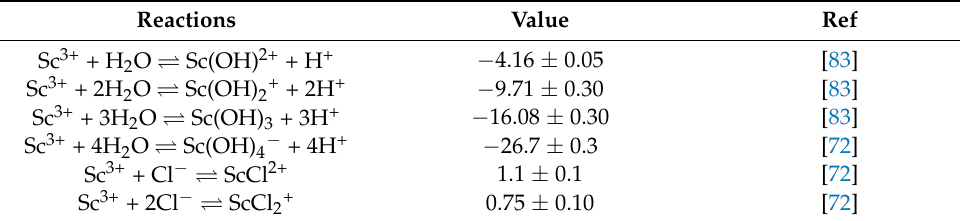
Table 7. Thermodynamic constants of scandium(III)